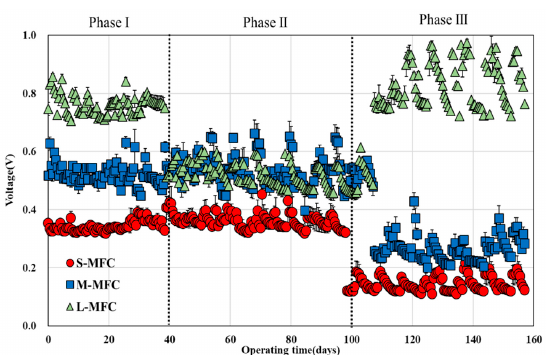
Figure 3. Voltage generation of S- (red circle), M- (blue square), and L-MFCs (green triangle) in a stacked MFC system according to the hydraulic flow connection mode and direction (phases I, II, and III). Appl. Sci. 2021 , 11 , 1019